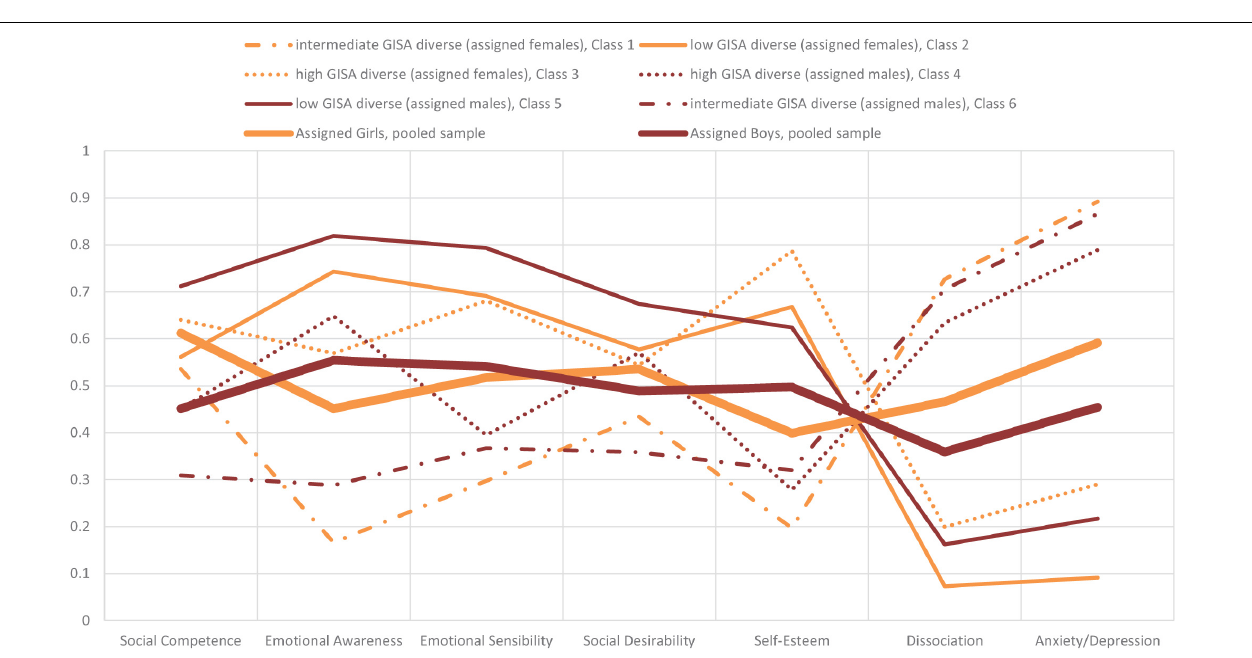
FIGURE 2 | Diagrammatic representation of the six identified GISA patterns plus the two pooled heteronormative gender categories “girls” and “boys” based on the seven indicators examined by latent class analysis, percentage of category 2 “high level of the specific indicator” in the respective class.